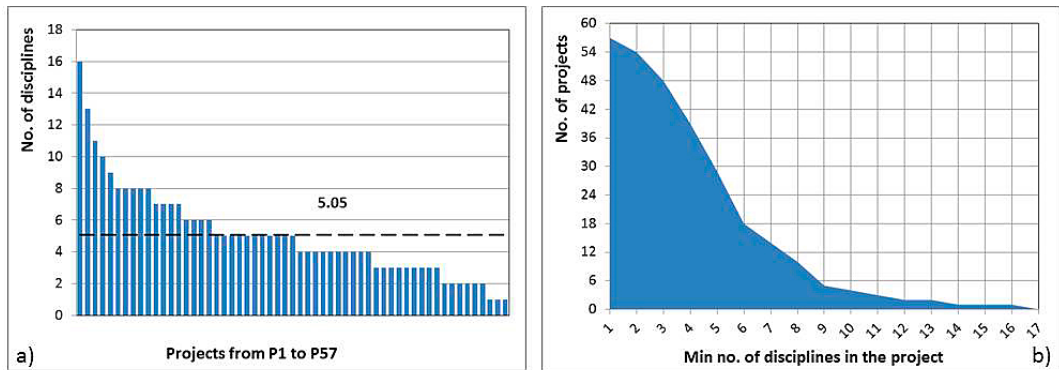
fig. 5. frequency (a) and cumulative frequency (b) of the number of disciplines involved in a single project (the dotted black line in the left chart a) indicates the average number of